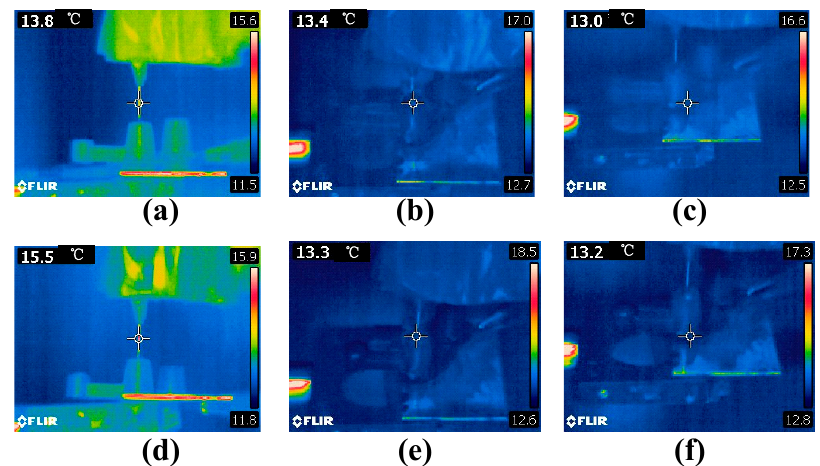
Figure 4. Temperatures of the two electrodes and the liquid silicone at the applied voltages of 2 kV and 9.2 kV: ( a – c ) are the infrared images of the needle, liquid, and indium tin oxide (ITO) glass at the voltage of 2.0 kV, while ( d – f ) are the infrared images of the needle, liquid, and ITO glass at the voltage of 9.2 kV.